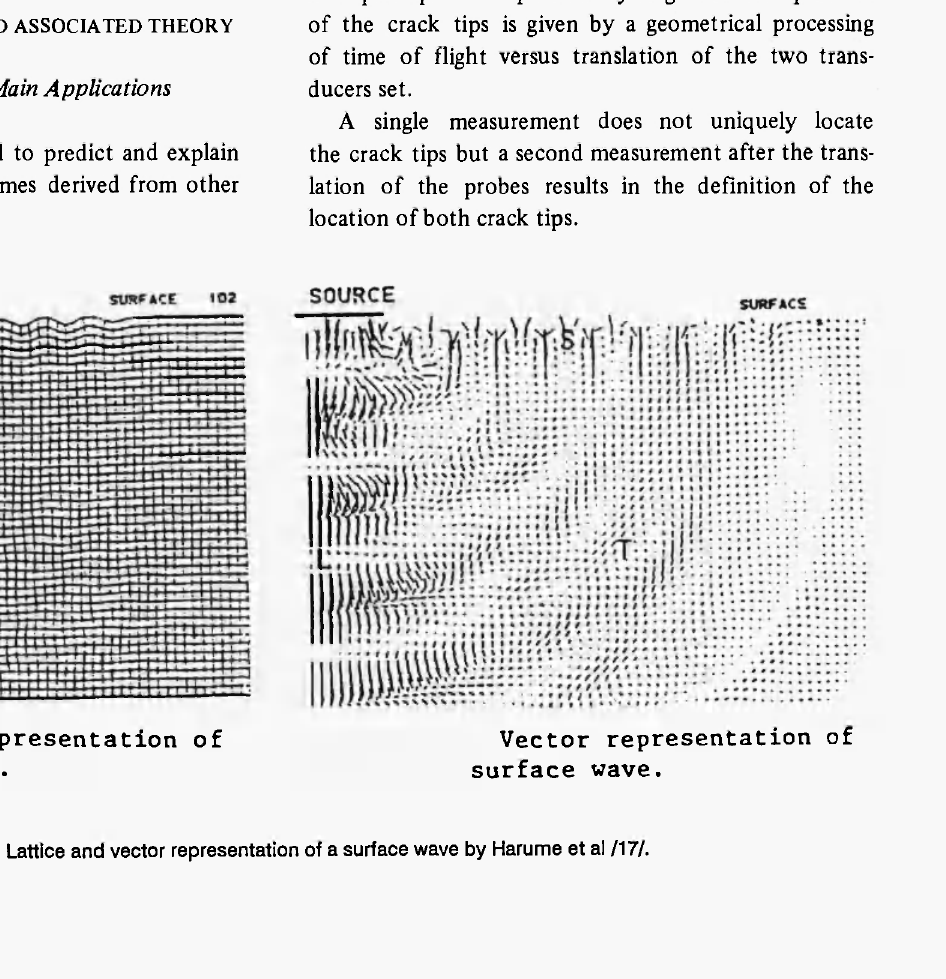
Fig. 12: Lattice and vector representation of a surface wave by Harume et al